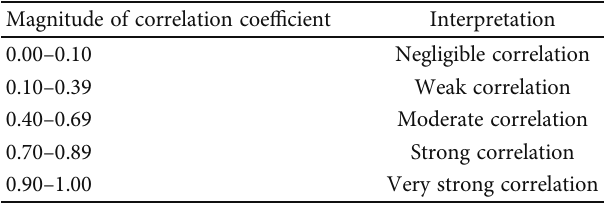
Table 2: Correlation Coe ffi cient Strength Indication.